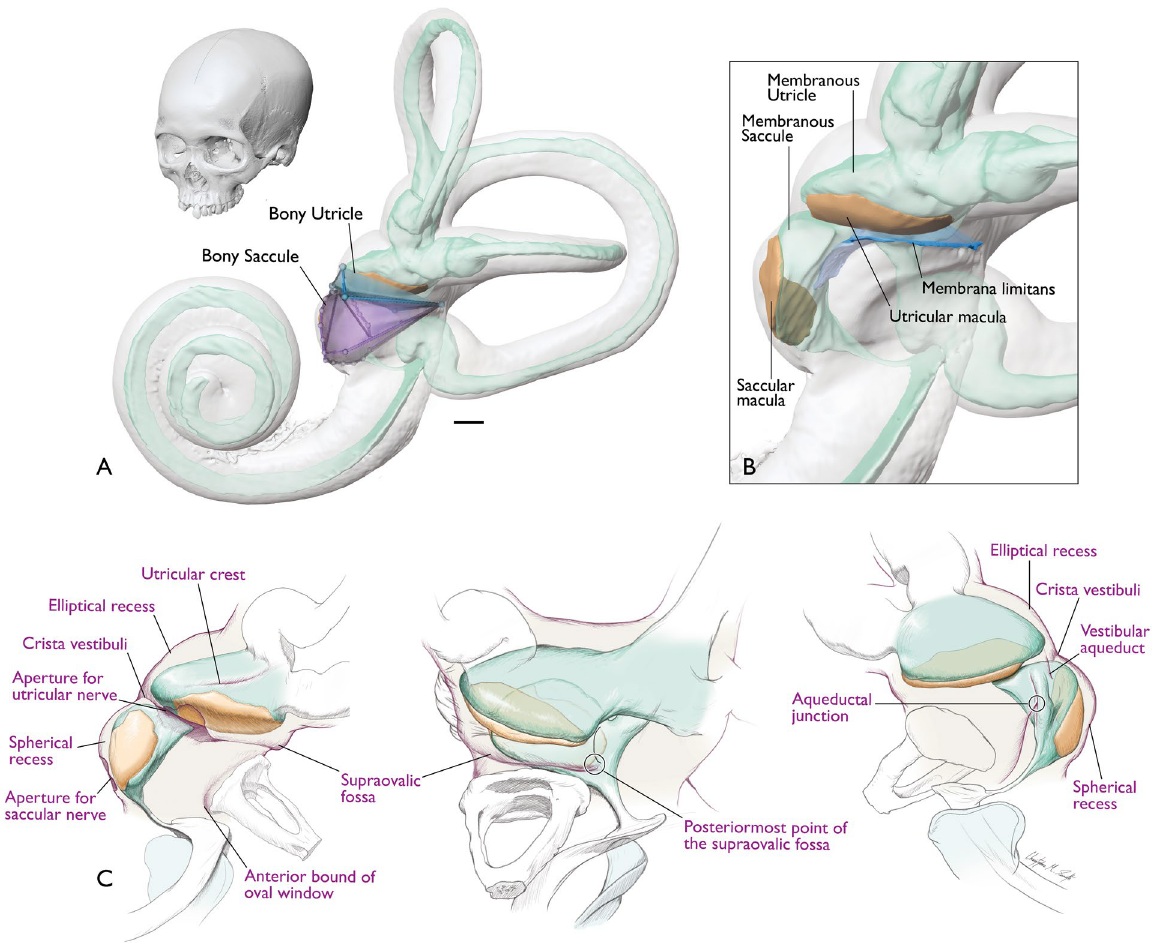
Figure 5. Anatomy of the human otolith system. ( A ) Schematized model of bony utricle and bony saccule structure (blue and purple wireframes, respectively) in anterolateral view superimposed onto the membranous labyrinth and ML. Cranium shows head orientation. ( B ) Enlarged view from A showing membranous structure. ( C ) Drawing of the labyrinth (purple) outlining bony features that reflect membranous otolith organ structure (green) and maculae (orange). Scale bar = 1 mm. Illustration by